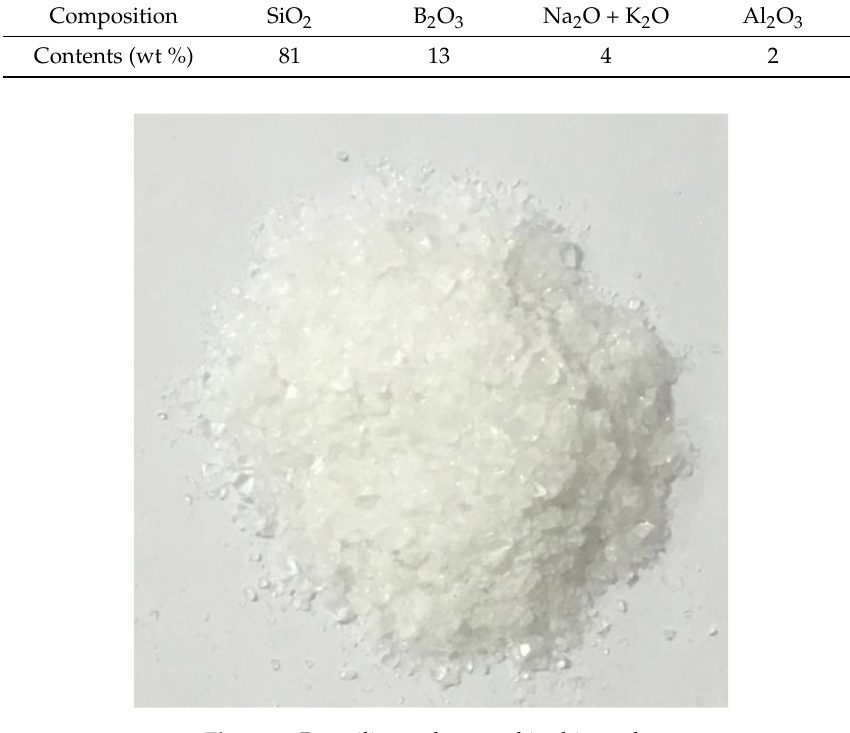
Figure 1. Borosilicate glass used in this study.